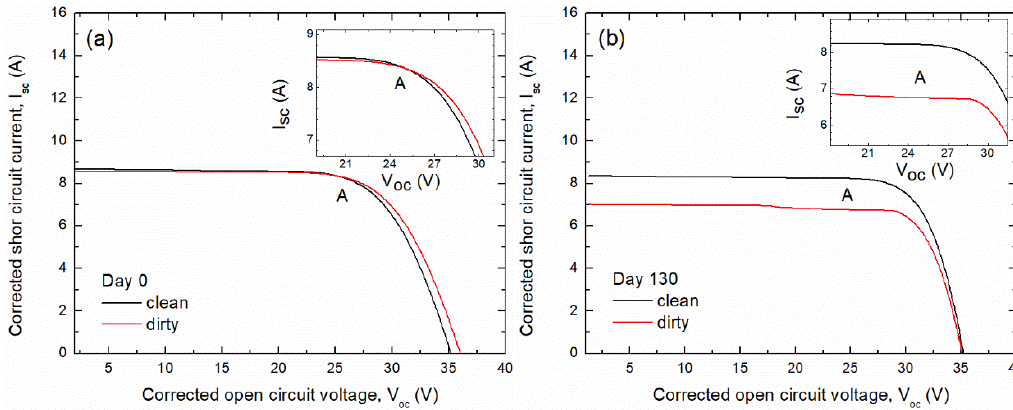
Figure 10. ( a ) Characteristic curve for the measurement of day 1. Small differences are observed. ( b ) Characteristic curve for the measurement of day 130. The distance in the curve amplitude is more highlighted.